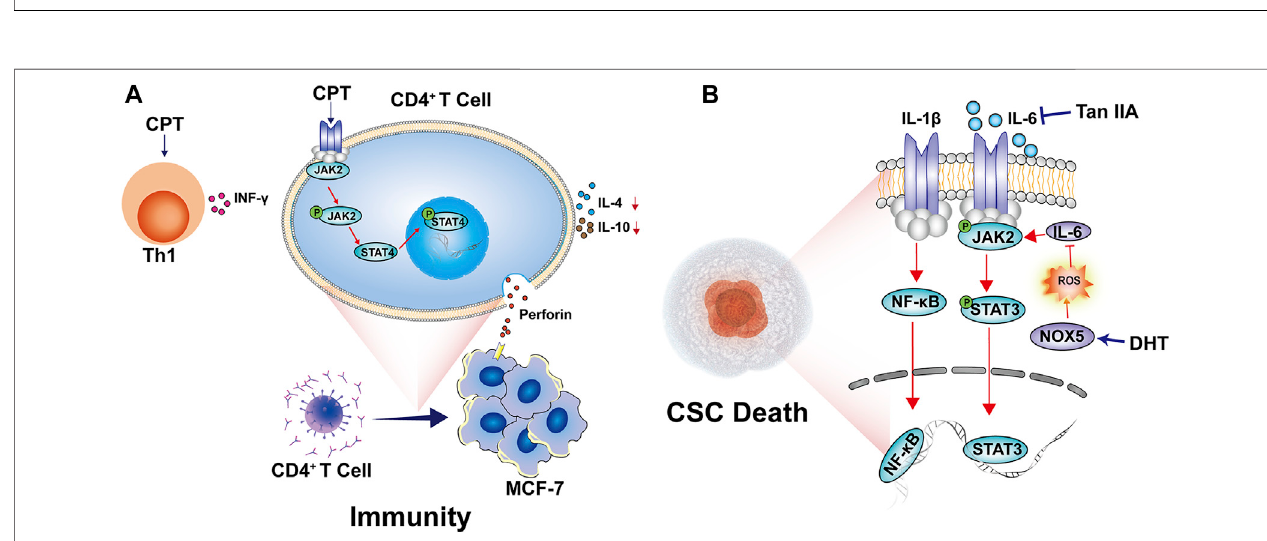
FIGURE 5 | The mechanisms by which S. miltiorrhiza bioactive constituents modulate breast cancer immunity and CSC manifestation. (A) CPT enhances perforin production in CD4 + T cells by up-regulating phosphorylated JAK2 and STAT4, promoting immune response differentiates to Th1 type. (B) DHT-activated NOX5 expressionpromotesROSgenerationwhichinhibitsIL-6/STAT3signalingpathway.TanIIAinhibitstheexpressionlevelsofIL-6expression,STAT3phosphorylation,and NF- κ B p65 nucleus translation, leading to breast CSCs death.